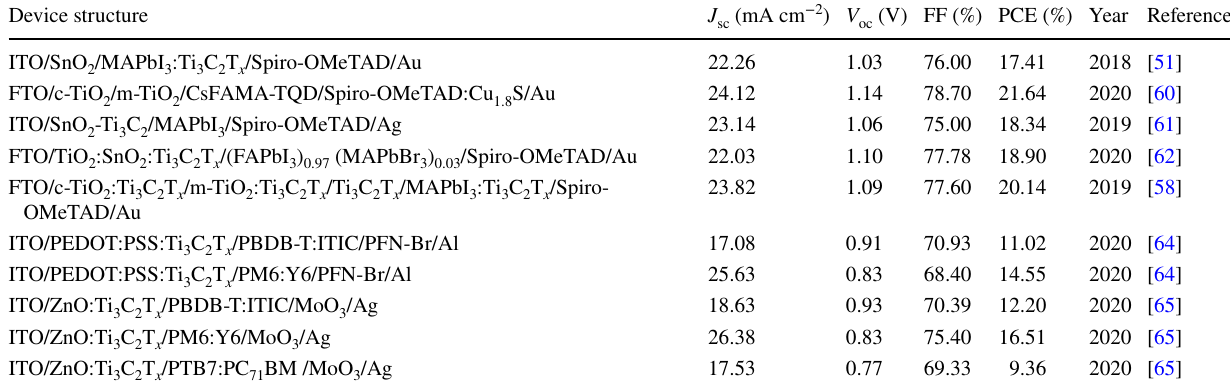
Table 2 Summary of the key parameters for the solar cells employing MXenes as an additive Device structure